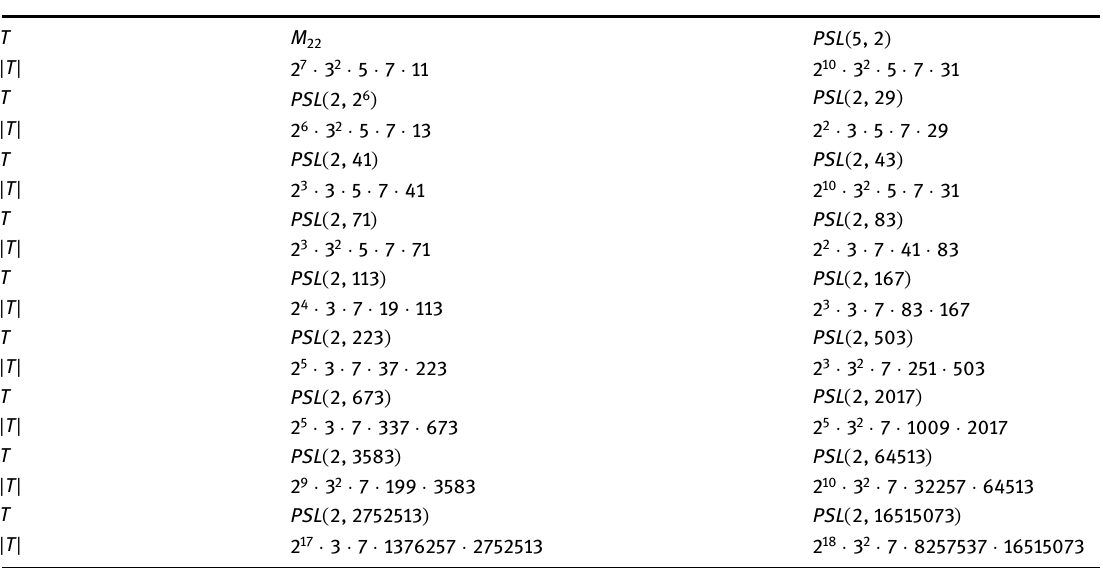
Table 3: The simple K 5 - groups in Lemma 3.1 T M